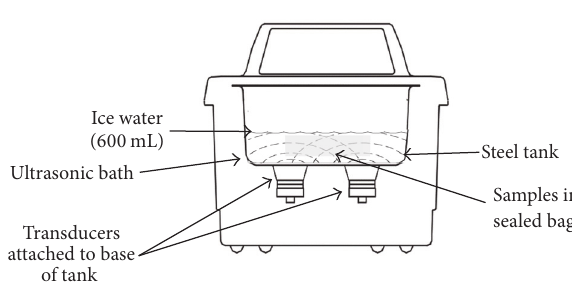
Figure 1: Schematic diagram of the experimental